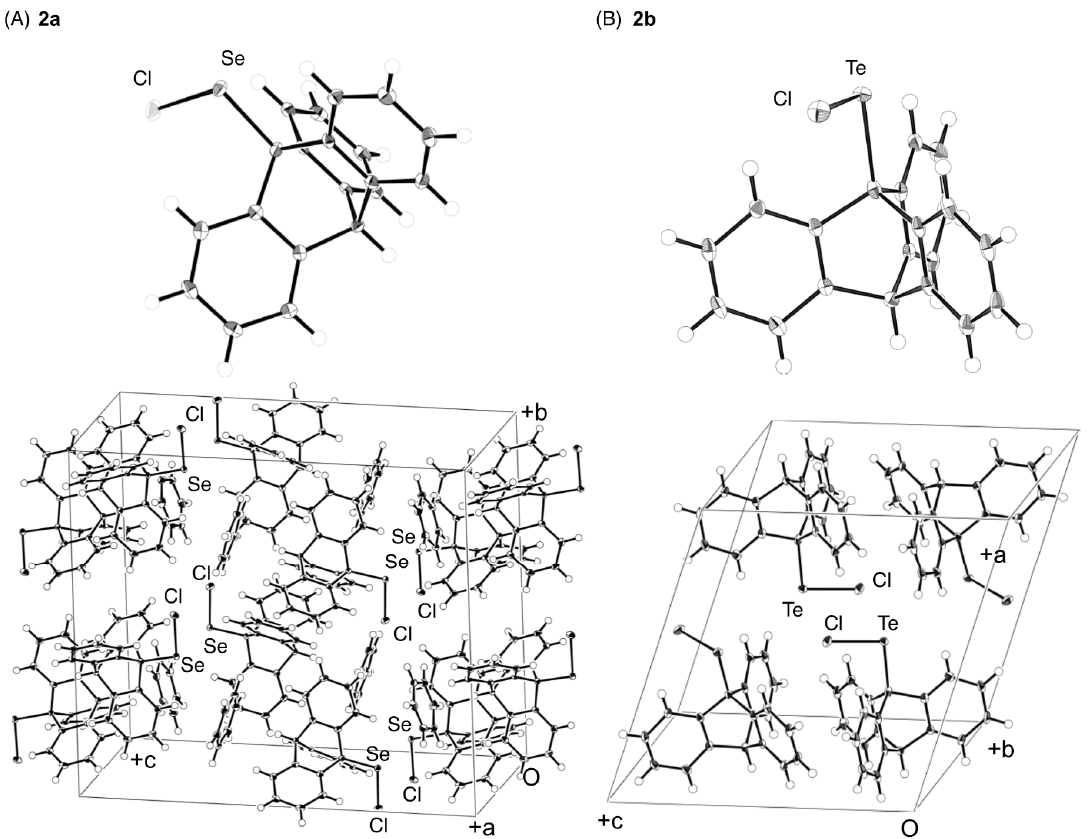
Figure 1. Molecular structures (ORTEP drawing at 50% probability) and crystal packing of (A) [ 2a·benzene ] and ( B ) 2b with atomic displacement parameters set at 50% probability. Selected bond lengths (Å) and angles (°): ( A ) Se–Cl, 2.1860(7); Se–C, 1.965(2); C–Se–Cl, 99.93(6), ( B ) Te–Cl, 2.348(1); Te–C, 2.166(3); C–Te–Cl, 96.38(9). Intermolecular atom-atom distances (Å): ( A ) Se···Se, 5.1687(3); Se···Cl, 5.5440(6); Cl···Cl, 5.6875(6), ( B ) Te···Te, 5.3089(7); Te···Cl, 4.395(1); Cl···Cl, 4.634(1).